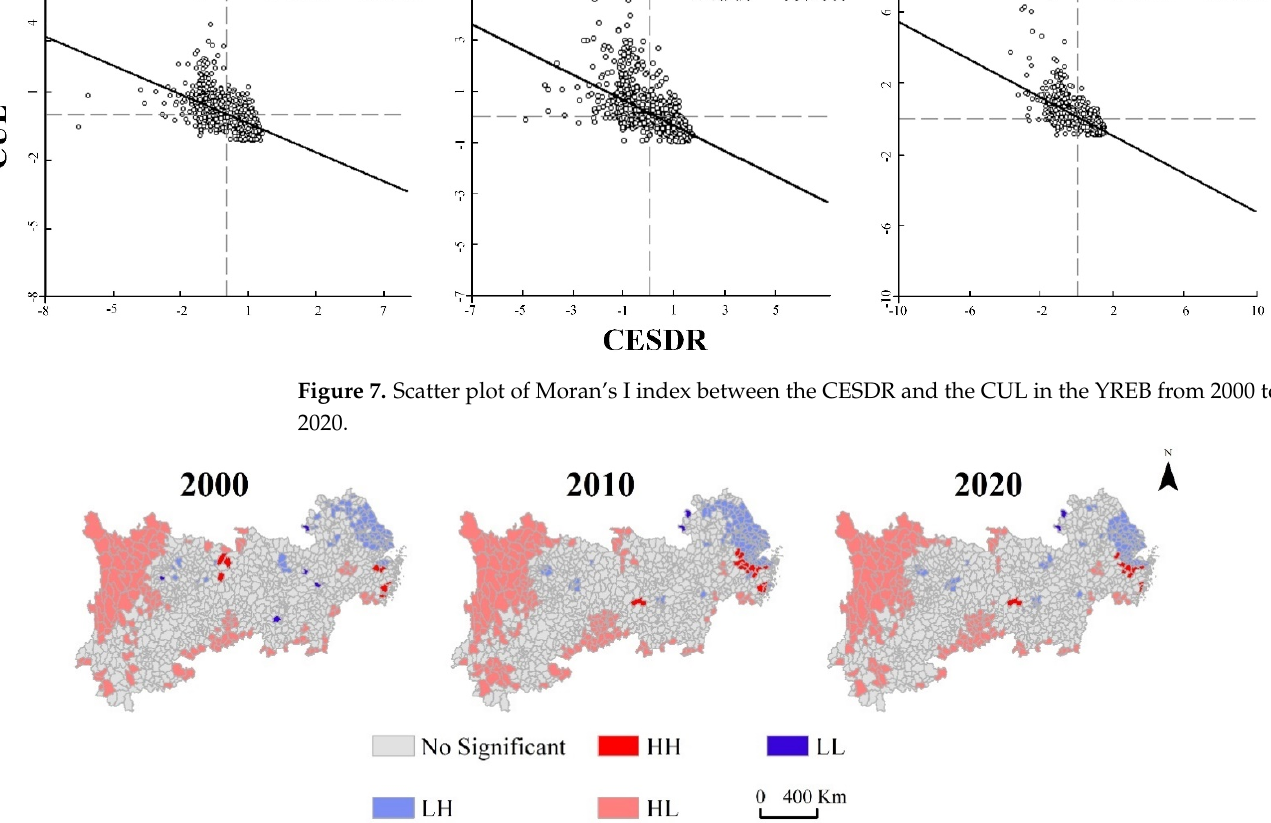
Figure 8. The local bivariate Moran’s I clustering graph between the CESDR and the CUL in the YREB from 2000 to 2020. (CESDR: comprehensive supply–demand ratio; CUL: comprehensive urbanization level; HH: high CESDR value and high CUL; HL: high CESDR value and low CUL; LH: low CESDR value and high CUL; LL: low CESDR value and low CUL).